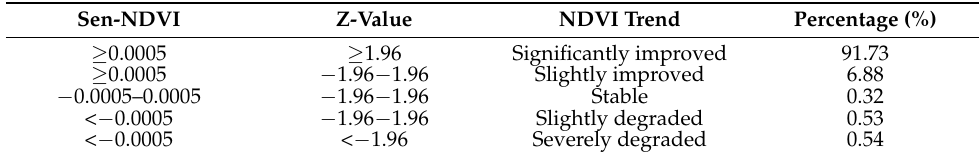
Table 5. Trend of the NDVI in the